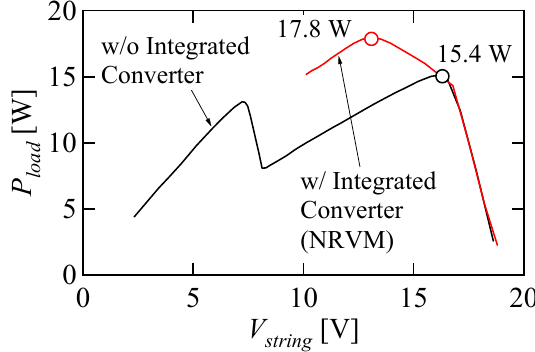
Figure 18. DC equivalent circuit-based simulation results.